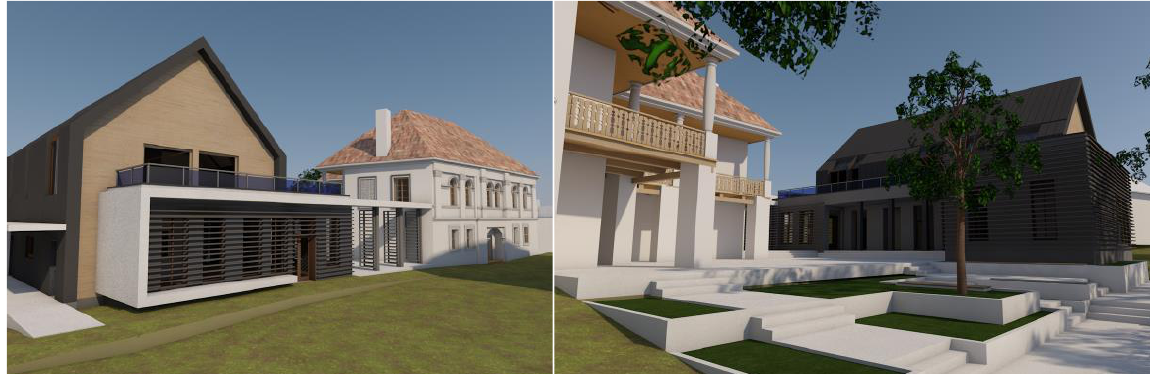
Figures 23, 24: Project for Roşia Montană Community Centre - front and backyard view